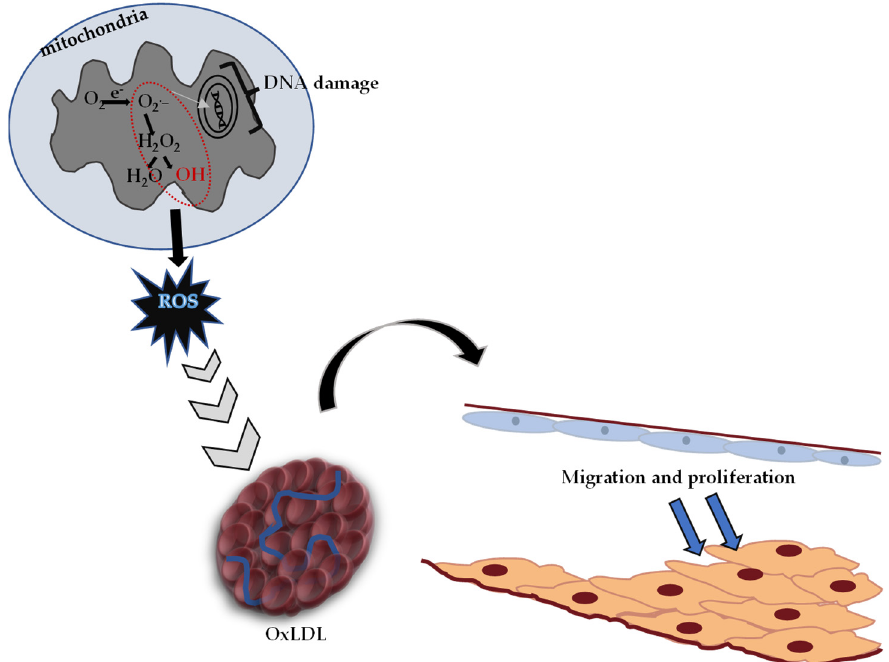
Figure 4. Reactive oxygen species (ROS) causing oxidative stress, oxidized low-density lipoprotein (OxLDL) and atherosclerotic plaque formation (adapted from ref. [129]).